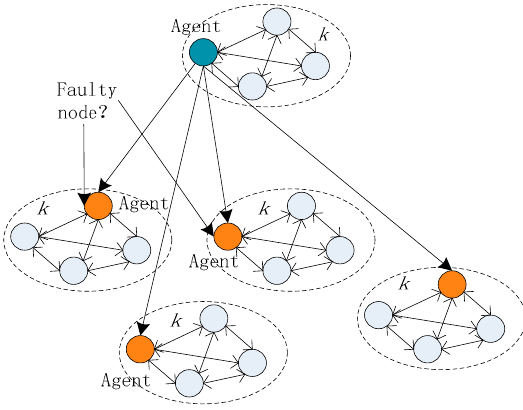
Figure 6. When the agents are faulty nodes.